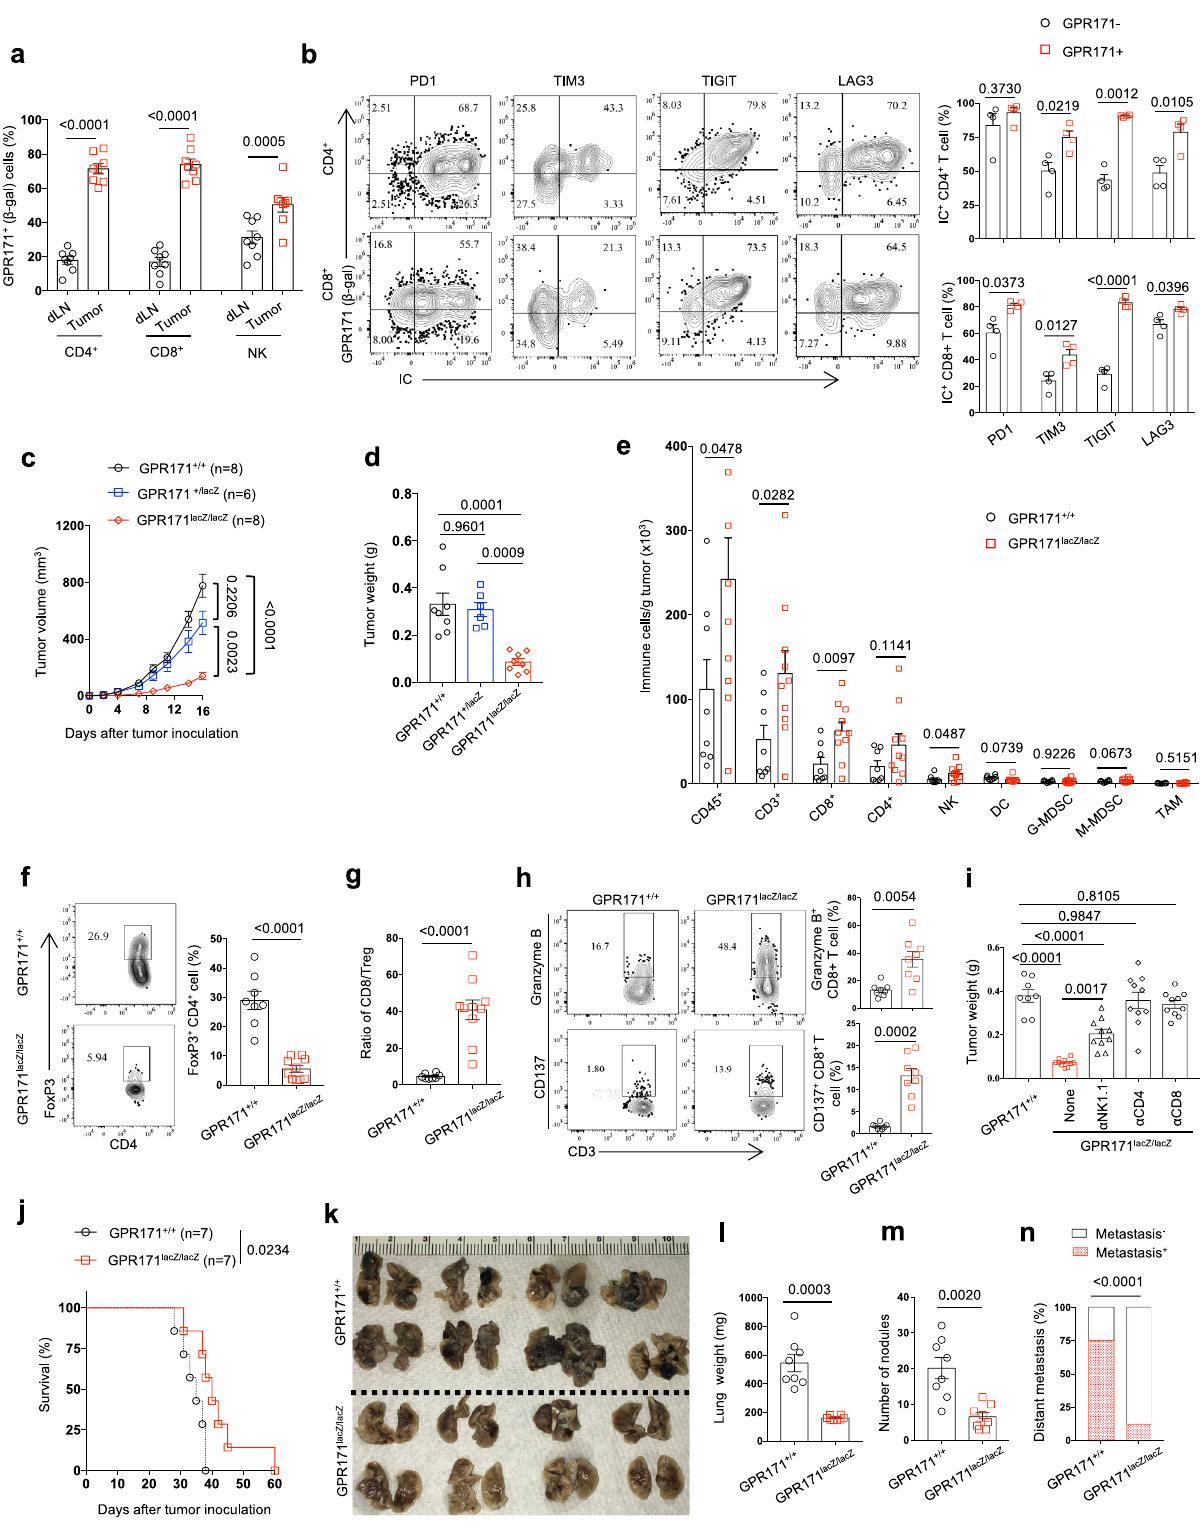
resistant to ICB therapy. GPR171 antagonist alone had no effect on tumor growth or mouse survival once B16F10 tumors were established. As expected, the treatment of ICB (PD-L1 and CTLA-4 mAbs) only displayed minor antitumor effects in established B16F10 tumors. However, the inclusion of GPR171